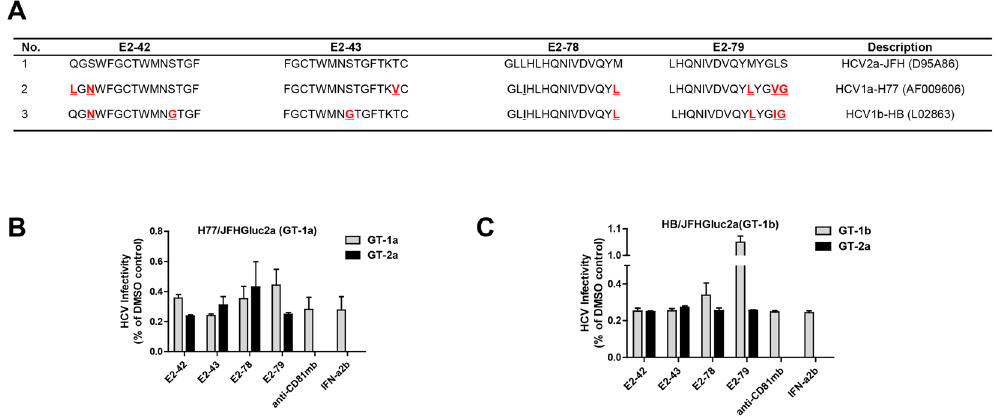
Figure 3. The inhibitory effects of the peptides on different genotypes of HCVcc. ( A ) Amino acid sequences of peptides from various HCV genotypes. ( B , C ) Inhibitory effects of peptides from genotypes 1a and 2a against chimeric HCVcc H77/JFHGluc2a ( B ) and HB/JFHGluc2a ( C ). Each bar represents the average of triplicate data points, with the standard deviation indicated by the error